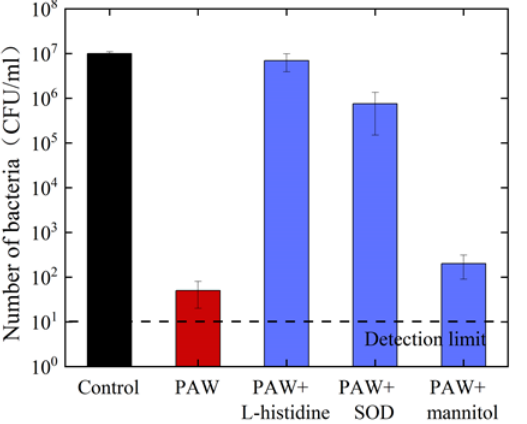
Figure 16. The bactericidal effect of PATW after adding different scavengers.